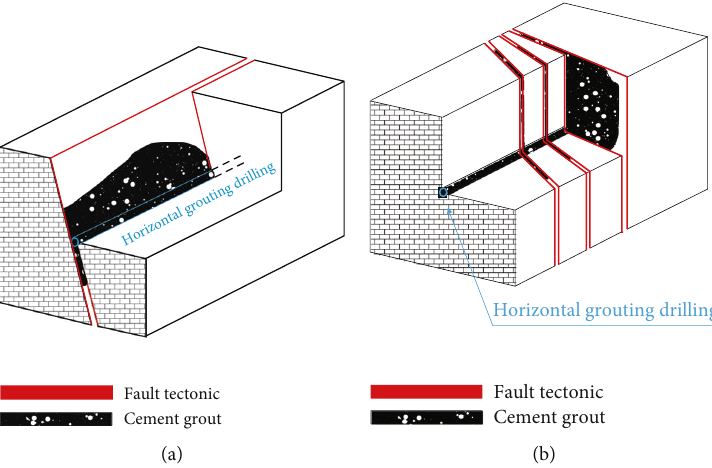
Figure 3: Schematic diagram of grouting e ff ect at di ff erent intersection angles between ground controlled directional bedding hole orientation and